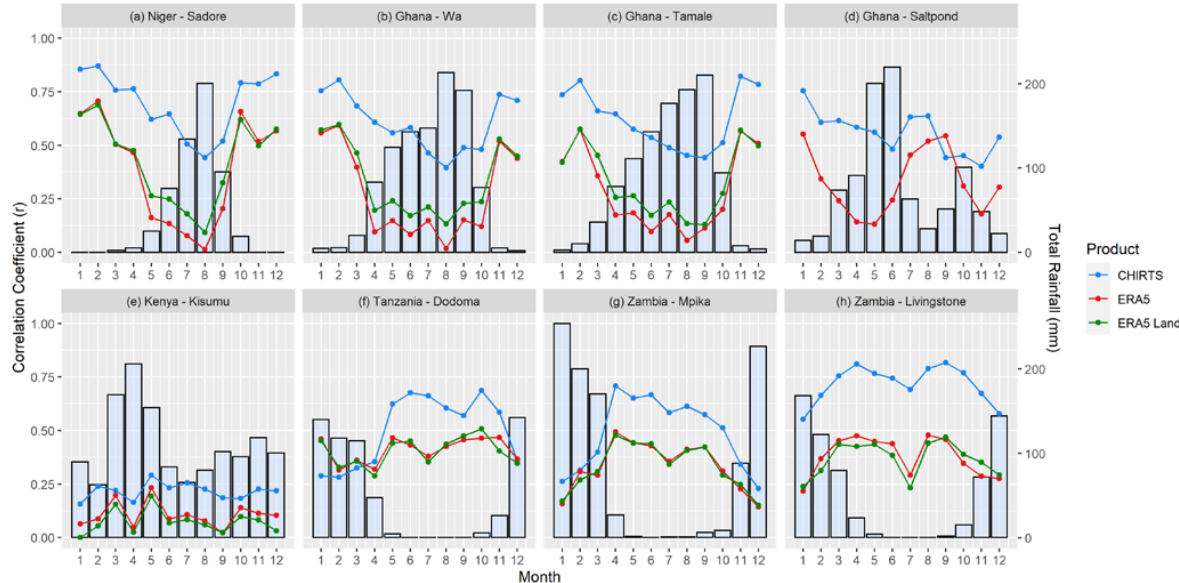
Figure 3. The lines show the correlation of daily minimum temperatures for each month between the station data and CHIRTS (blue), ERA5 (red) and ERA5-Land (green) at the stations in Niger and Ghana ( a – d ) and Kenya, Tanzania and Zambia ( e – h ). The light blue bars show the mean monthly total rainfall calculated from the station data.